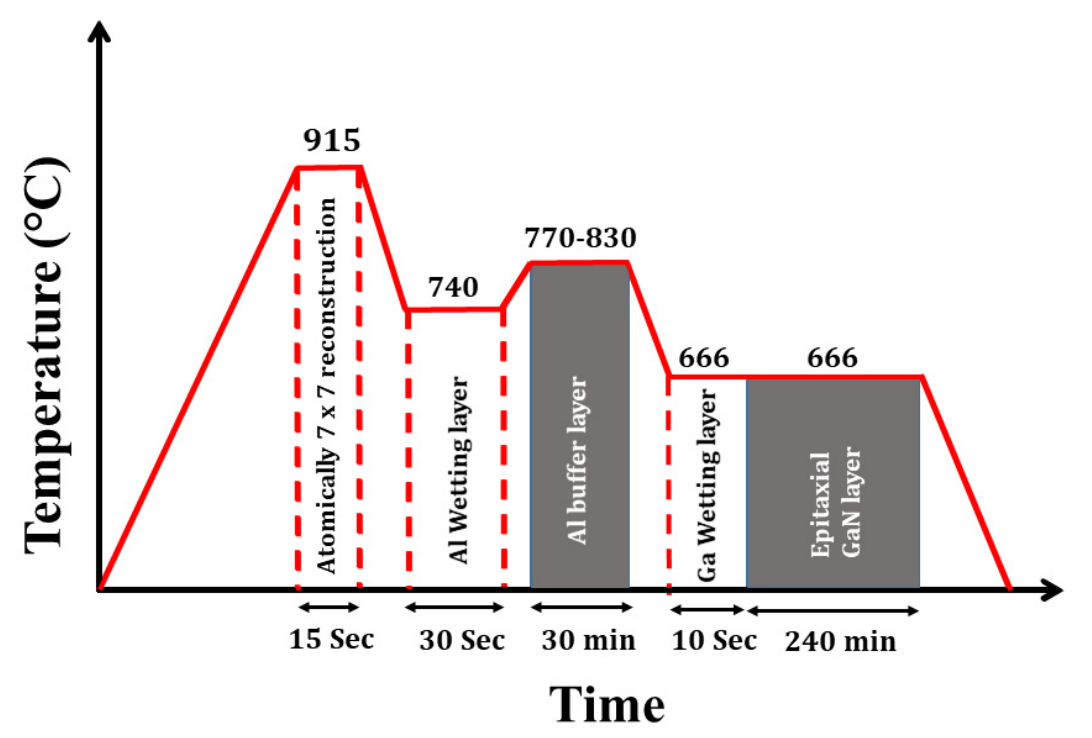
Figure 1. Growth dynamics of GaN/AlN heterostructure.